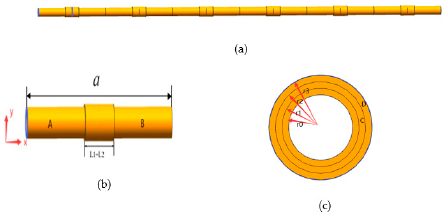
Figure 1. The periodic pipeline structure: ( a ) partly periodic structure; ( b ) single periodic structure; and ( c ) local oscillator cross section. Table 1. The physical parameters of the periodic pipeline material.